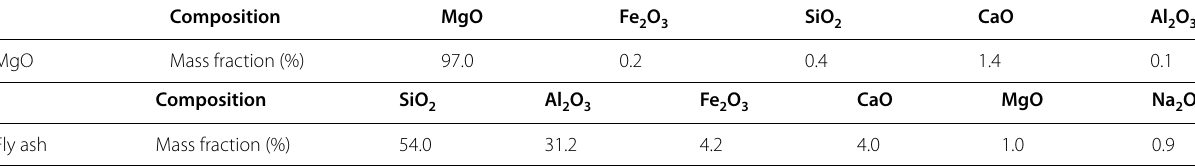
Table 1 Major chemical composition of MgO and fly ash.